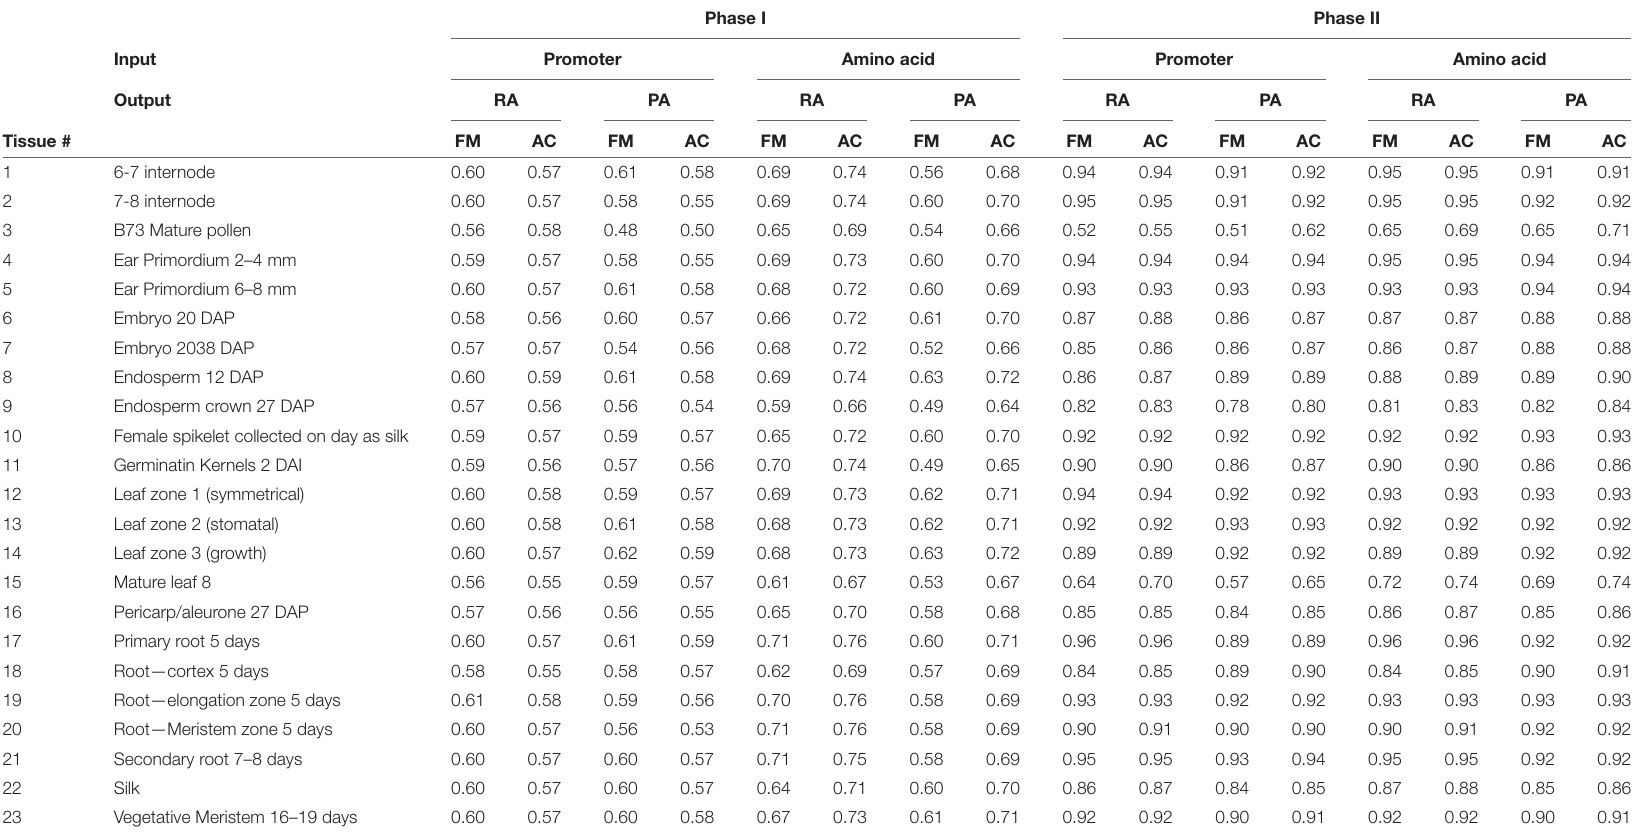
TABLE 3 | Our methodology generated thousands of classifiers to predict gene expression for 23